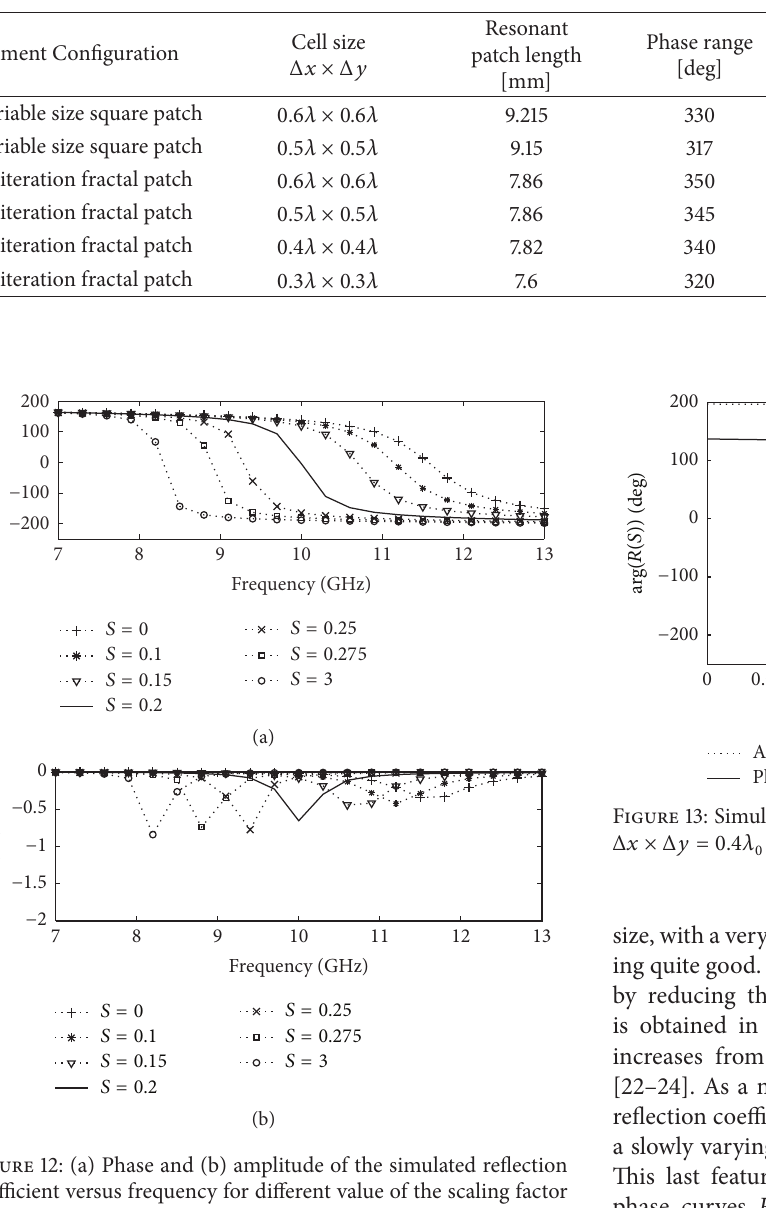
Table 2: Fractal unit cell performances (1st iteration Minkowski patch).